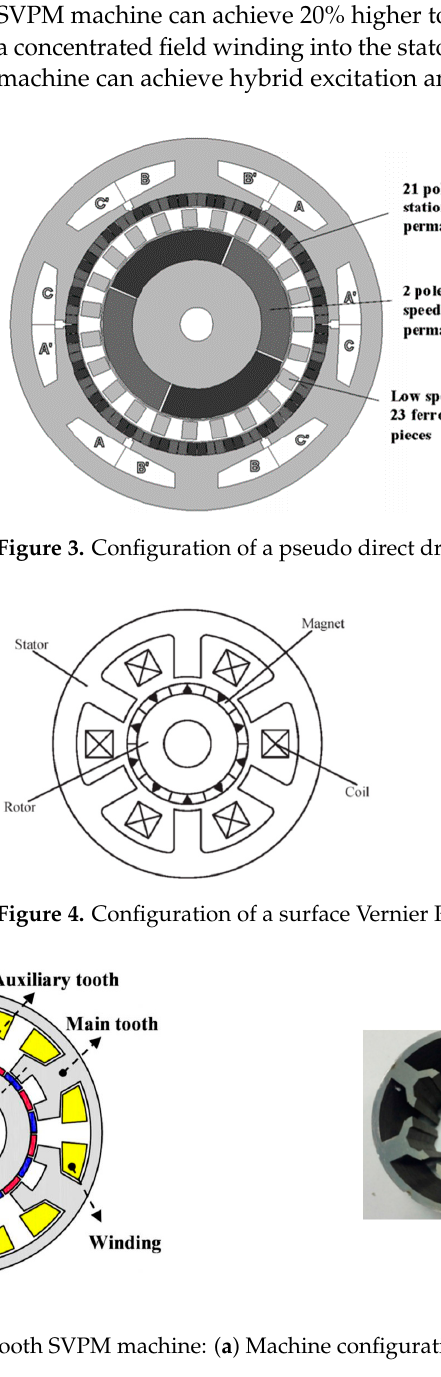
( b ) Figure 6. Hybrid-excited split-tooth SVPM machine: ( a ) 3D structure; ( b ) Cross-sectional view [20]. The rotors of all the aforementioned surface-type FMPM machines have PMs mounted on the surface. Since the PMs have a relatively weak mechanical strength, an additional sleeve is needed to protect the PMs from being damaged by the large centrif- ugal force when the rotor runs at high speeds. The protection sleeve increases the air-gap length and reduces the output torque. Flux-reversal PM (FRPM) machines are good can- didates to solve this problem, which employ PMs on the surface of the stator teeth and the rotor has a robust structure with only salient poles. Considering the magnetization methods, FRPM machines can be divided into two categories, as shown in Figure 7. In Figure 7a, the magnets on the adjacent stator teeth are reversely magnetized, which is referred to as NS-SN. While in Figure 7b, the magnets on all the stator teeth are magnet- ized in the same way, which is referred as NS-NS. The back EMF prediction method based on air-gap field modulation theory was developed in [21]. The influence of adja- cent teeth magnet polarities on the performance of FRPM machines was comprehensively investigated in [22], and the results revealed that FRPM machine with four magnet pieces mounted on each stator tooth and magnets on adjacent stator teeth that are of opposite polarities can achieve the largest output torque. Large PM leakage flux is one of the major drawbacks of FRPM machines, which causes partial magnetic saturation and results in a low power factor. An asymmetric stator pole FRPM machine was developed to reduce the leakage flux [23], whose configuration is shown in Figure 8. The asymmetric ar- rangement of magnets generates biased coil flux linkage, which results in torque im- provement as well. The simulation and experimental results showed that this asymmetric stator pole FRPM machine can achieve 24.16% higher torque than its conventional counterpart, and a power factor of 0.76 was measured.